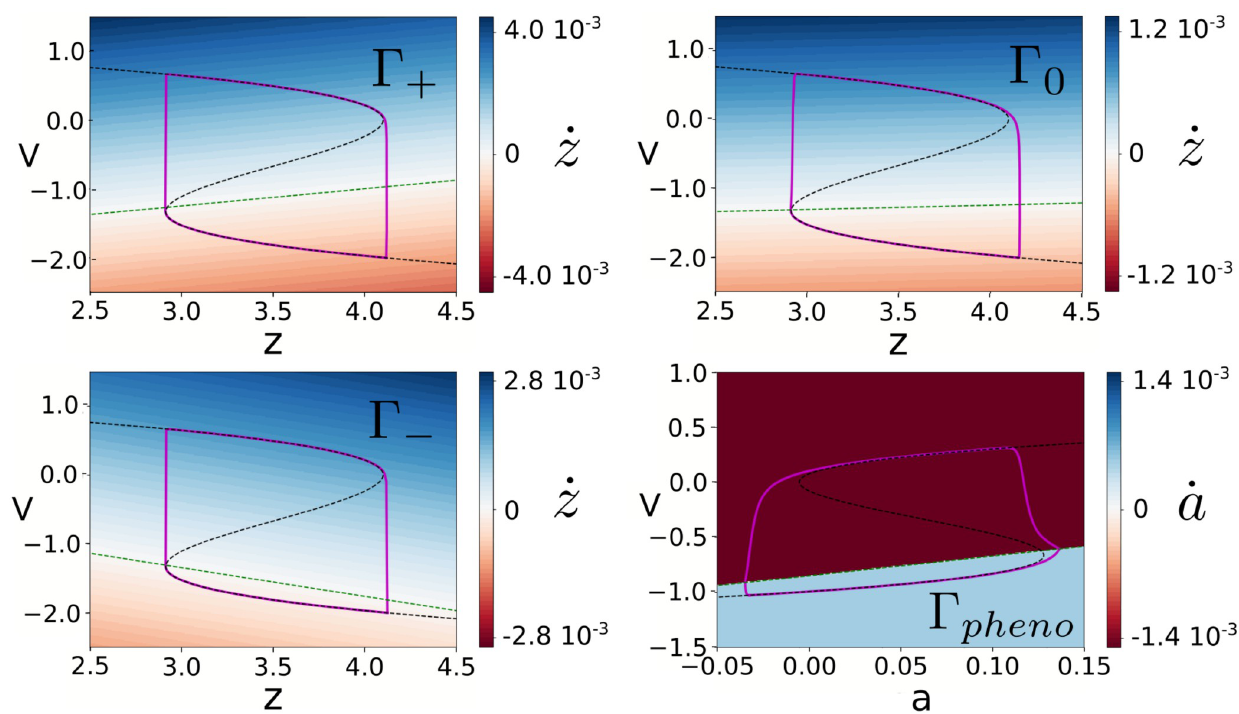
Fig 11. Slow vector field for the reduced epileptor and the phenomenor. Each cycle is depicted in purple, the v-nullcline in black and the slow nullcline in green. Notice that the direction of the slow variable in both models is flipped, and thus is also the motion over the cycles and the sign of the derivative of the slow vector field in the fast direction g 0 ð x ; y Þ x